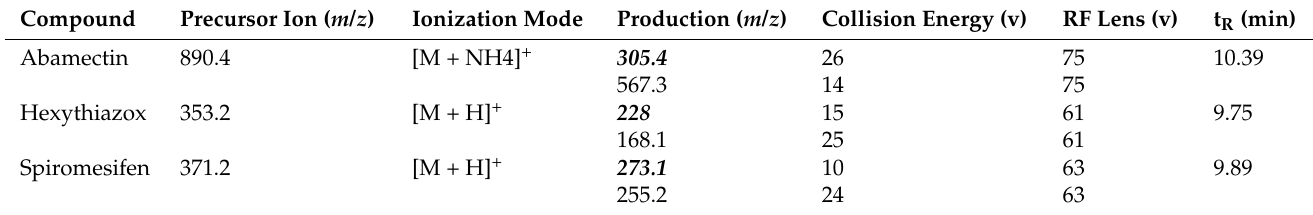
Table 1. LC-MS/MS